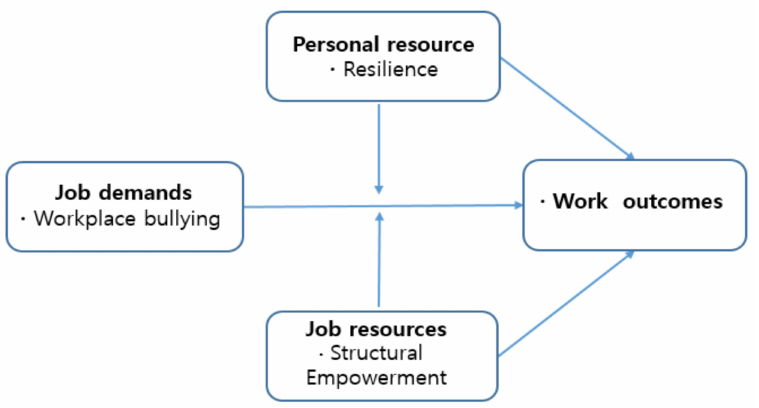
Figure 1. A conceptual framework based on the job demands–job resources